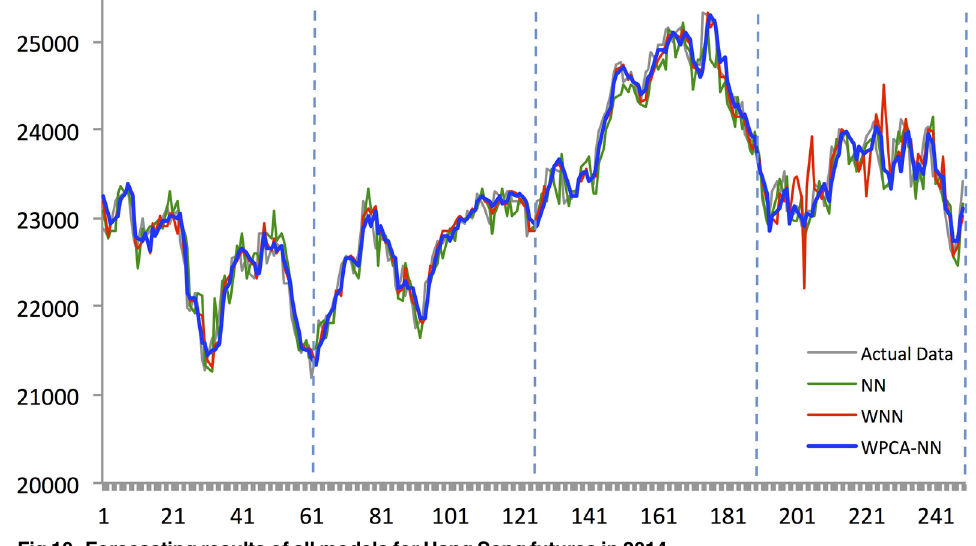
Fig 10. Forecasting results of all models for Hang Seng futures in